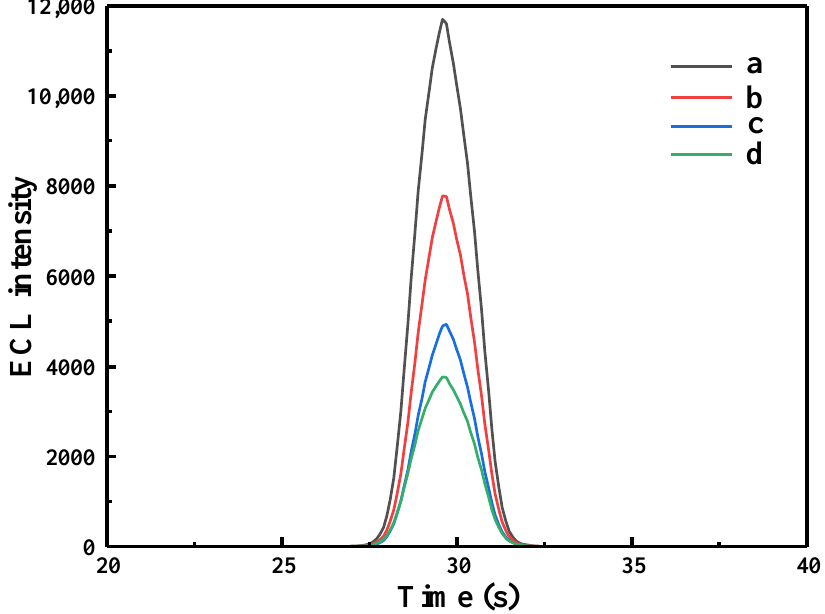
Figure 5. ECL diagram of modified electrodes in different states: ( a ) GCE/Ru-Au-WS 2 , ( b ) GCE/Ru-Au-WS 2 /Ab, ( c ) GCE/Ru-Au-WS 2 /Ab/BSA, ( d ) GCE/Ru-Au-WS 2 /Ab/BSA/CEA. The effects of CEA incubation time and TPA concentration on the behavior of the biosensor were examined to maximize the performance of the manufactured immunosensor. The best signal from the biosensor platform was produced when the TPA concentration was 0.1 mol·L −1 and the culture time was 30 min, as shown in Figure 6A,B. As a result, these circumstances were chosen as the best parameters for further CEA detection.